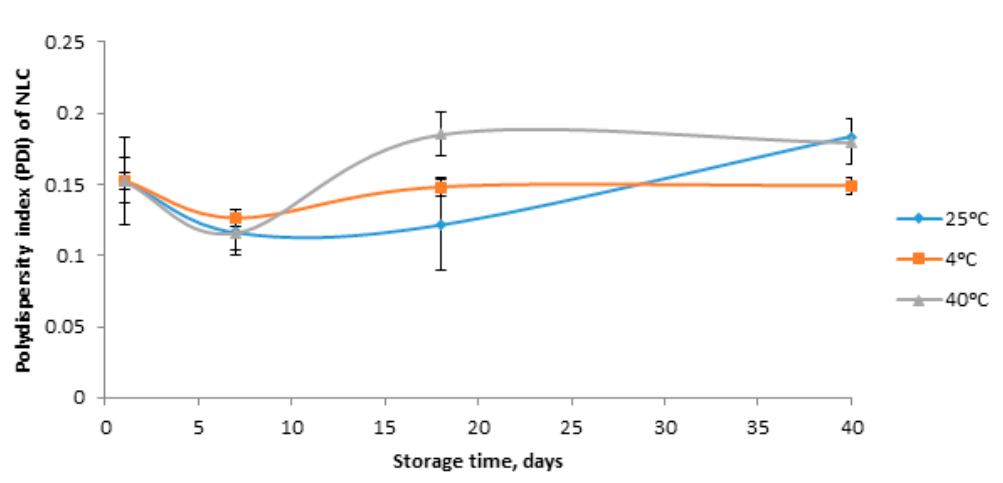
Figure 5. Changes of PDI of FDNLC during storage at 4 ◦ C, 25 ◦ C and 40 ◦ C throughout 40 days of study. Experiments were done in triplicate ( n =